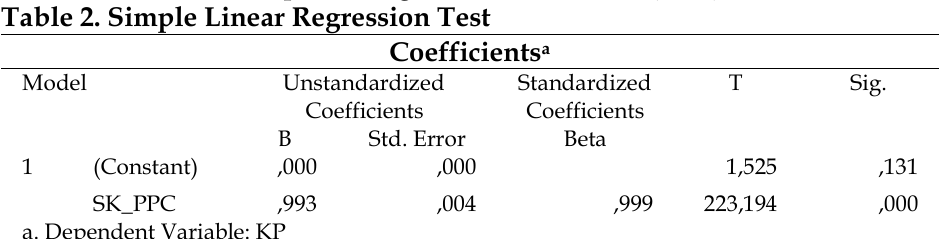
Table 2. Simple Linear Regression Test